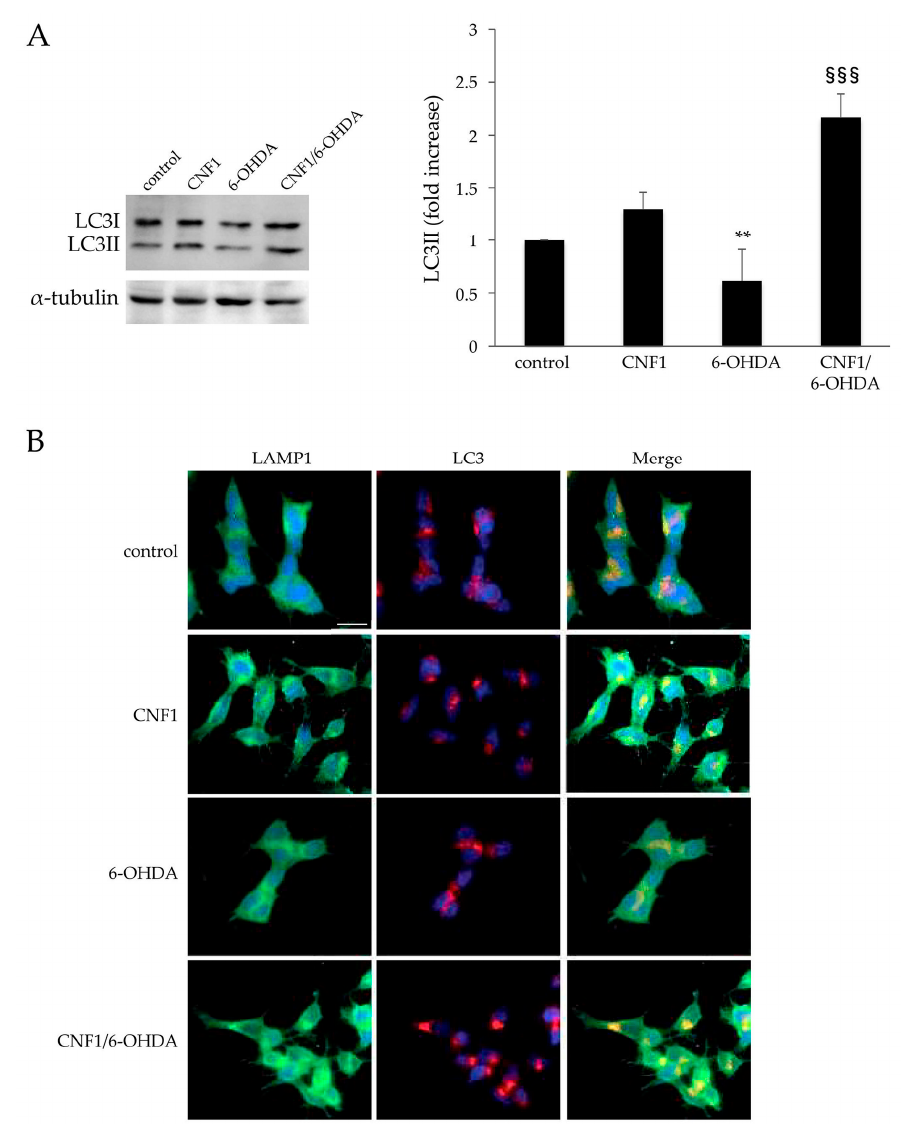
Figure 5. CNF1 triggers autophagy in SH-SY5Y cells. ( A ) Immunoblots (left panel) showing microtubule-associated proteins 1A/1B light chain 3 (LC3) (I and II) expression in SH-SY5Y cells. The amount of LC3II isoform is normalized as a function of α -tubulin (histogram, right panel). Note that 6-OHDA challenge reduced LC3-II levels and that CNF1 pre-treatment was able to counteract such a decrease. The graph reports the mean ± SEM from three different experiments. Results are expressed as fold increase relative to control (=1). ** p < 0.01 compared with control; §§§ p < 0.001 compared with 6-OHDA. ( B ) Fluorescence microscopy images of SH-SY5Y cells co-stained with anti-lysosomal-associated membrane protein 1 (LAMP1) (green), anti-LC3 (red) antibodies and with the nuclear dye Hoechst 33258 (blue). Note that there is a significant co-localization of LAMP1 and LC3 (merge) after treatment with CNF1 and in cells pre-treated with CNF1 before 6-OHDA treatment. Bar = 10 µ